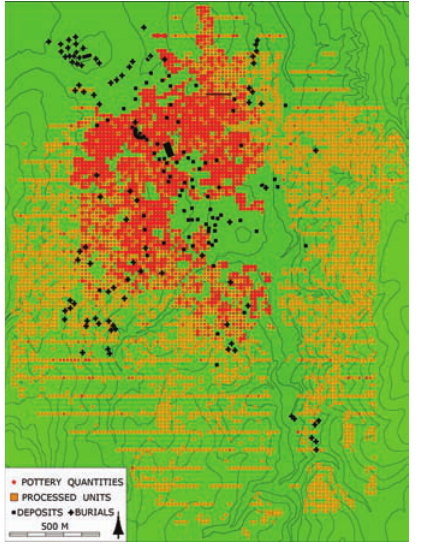
Figure 9 Roman evidence, excavations and surface pottery